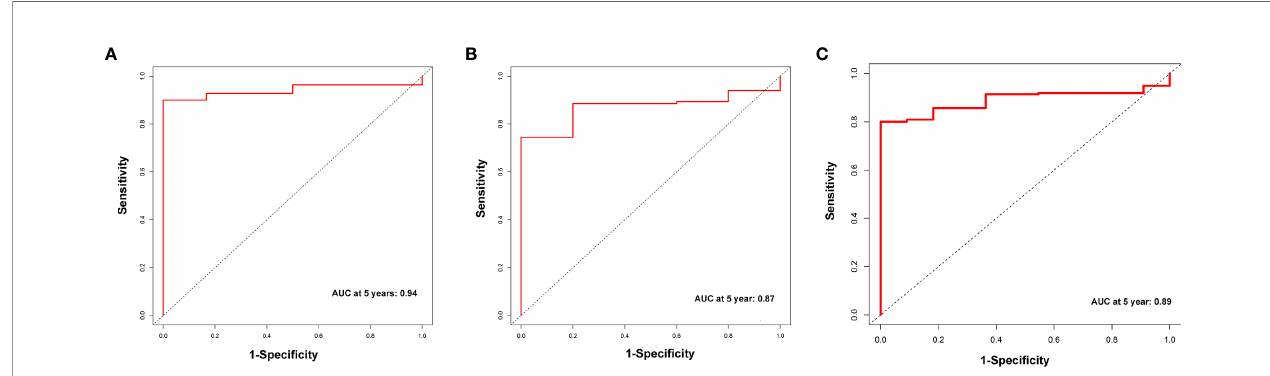
FIGURE 3 | The receiver operator curve (ROC) analysis for the m6A-related lncRNAs signature in the training dataset (A) , testing dataset (B) , and complete dataset (C) ,